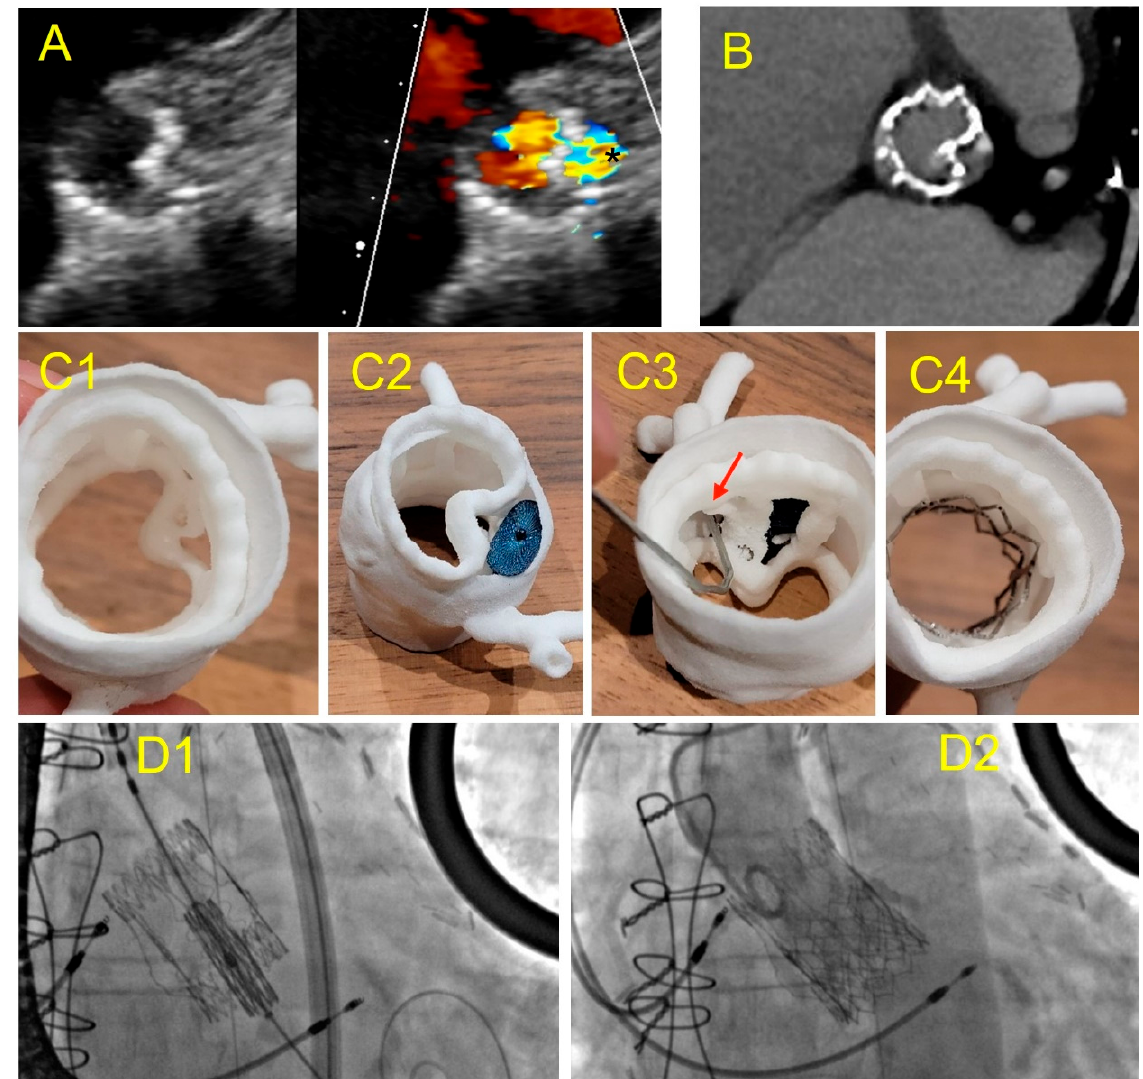
Figure 6. Case 3: PVL after Perceval Bio-prosthesis implantation. ( A ) Aortic TTE view: incomplete expansion of the prosthetic framework against the annular aortic wall (left) causing large PVL (*); ( B ) cardiac CT of the Perceval prosthesis showing an invagination of the prosthetic armature in a same view as ( A ); ( C ) 3D printed model in superior aortic view showing the gap between the aortic wall and the invaginated prosthetic armature ( C1 ); testing of an Amplatzer Valvular Plug III 14 × 5 mm ( C2 ) showing residual gap and obstruction of the left coronary ostium (( C3 )-red arrow); simulation of a TAVI valve-in-valve which allowed complete apposition of the Perceval framework to the aortic wall ( C4 ); ( D ) TAVI valve-in-valve procedure: implantation of an Edwards balloon expandable prosthesis ( D1 ) into Perceval armature without residual leakage ( D2 ).